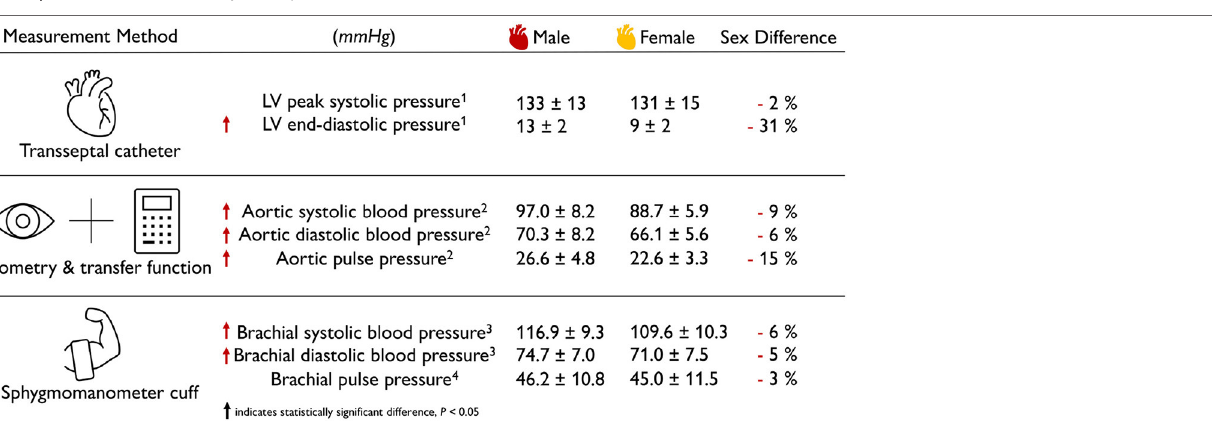
TABLE 3 | Sex differences in healthy blood pressure.